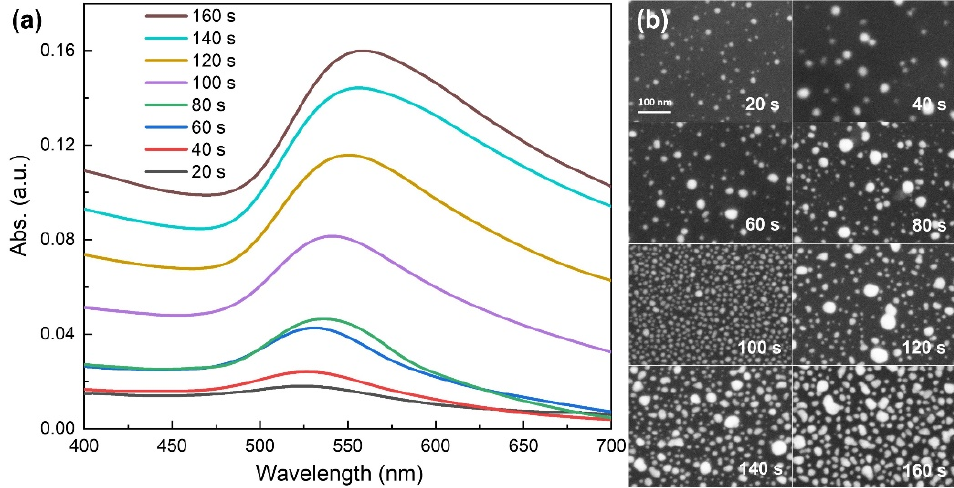
Figure 8. ( a ) Absorption spectra of Au nanoparticles on quartz substrates with different sputtering times; ( b ) The corresponding SEM images of Au nanoparticles.